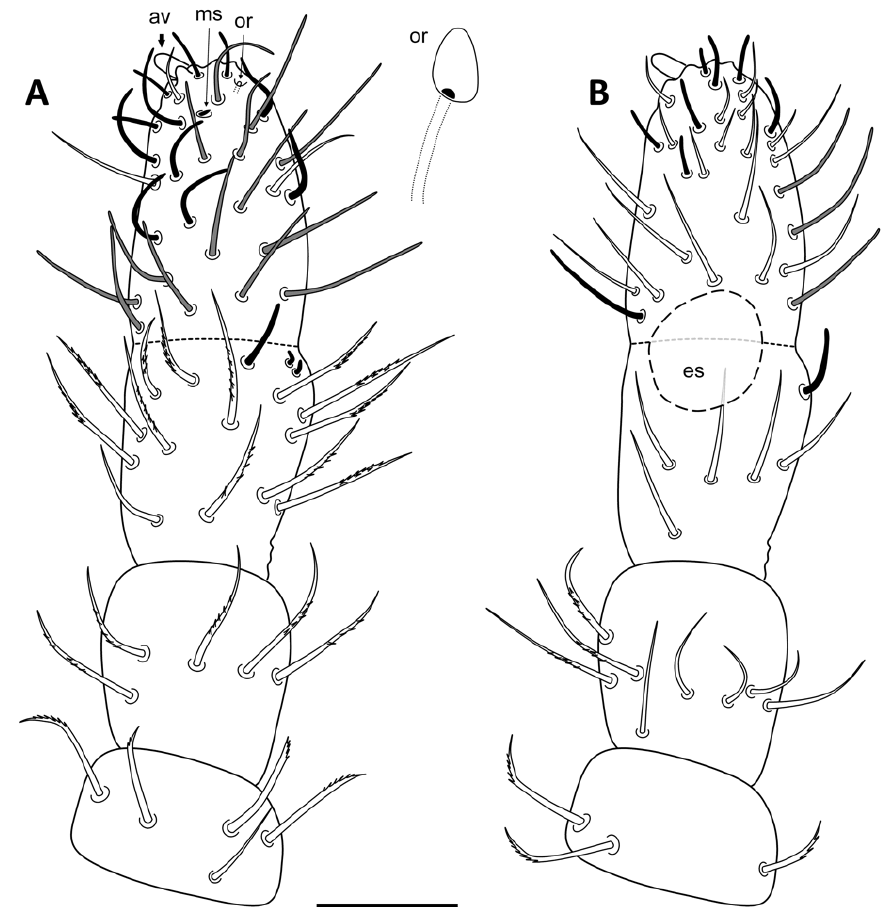
Figure 2. Ceratophysella meridionalis : antennal segments I to IV, dorsal view at left ( A ); ventral view at right ( B ) (av, apical vesicle; ms, microsensillum; or, subapical organite; es, eversible sac) (scale bar, 0.05 mm).